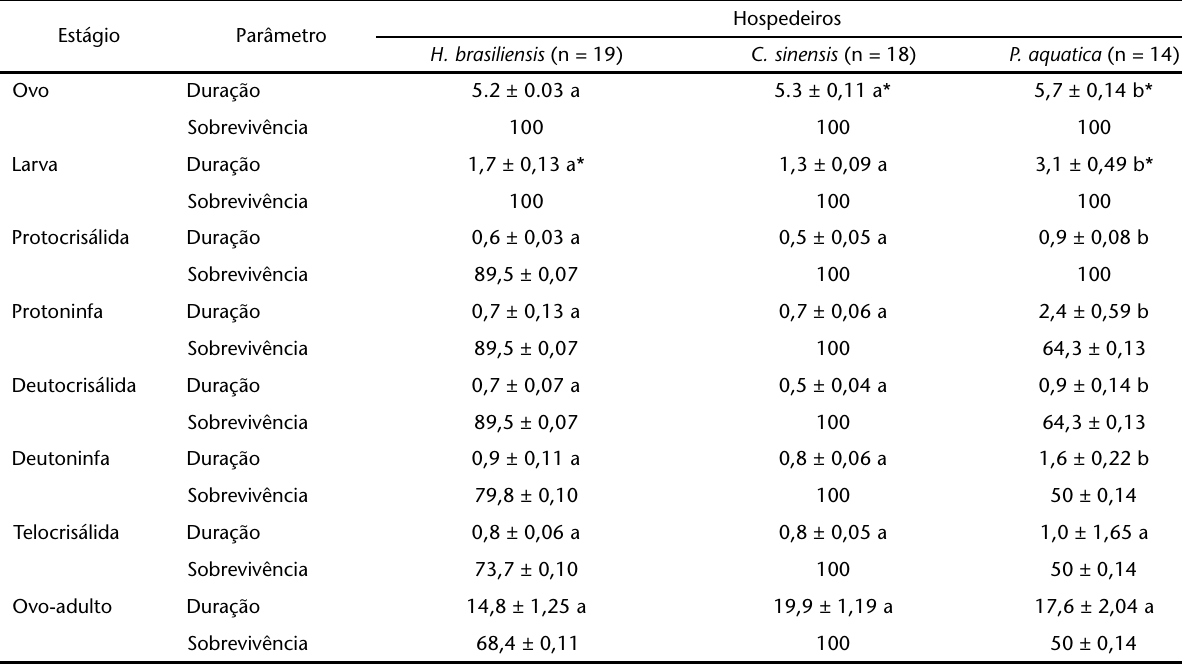
Tabela V. Duração (dias) e sobrevivência (%) dos estágios de ovo, larva, protocrisálida, protoninfa, deutocrisálida, deutoninfa, telocrisálida e período de ovo a adulto de indivíduos de E . banksi coletados e criados sobre seus hospedeiros de origem. BOD a 28 ± 1°C e 12 horas